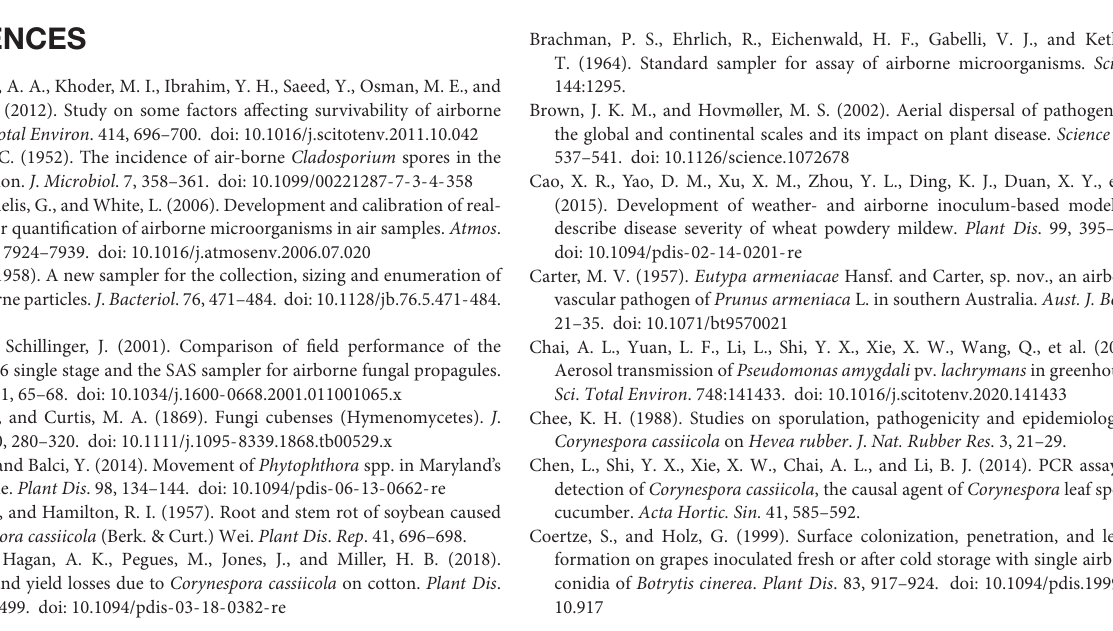
Supplementary Figure 2 | Schematic drawing of Corynespora cassiicola aerospore transmission experiment among donor and recipient cucumber plants in greenhouses. The greenhouses were equipped with ventilation openings (height of 1 m) on the sidewall and the top. The inoculation center (3 m × 1.5 m) was at the center of the greenhouse. Sampling sites (marked with yellow star) were 0, 1.5, 3, 4.5, 6, and 7.5 m away from the inoculation center. Supplementary Figure 3 | Verification of the airborne dispersal of Corynespora cassiicola in naturally infested greenhouses. (A1–A9) Symptoms observed on cucumber TLS plants from greenhouse I to greenhouse IX. (A0) Healthy cucumber plants from the control greenhouse. (B1–B9) Colonies of airborne microbes collected from greenhouse I to greenhouse IX. (B0) Colonies of airborne microbes collected from the control greenhouse. (C1–C9) Colony characteristics of